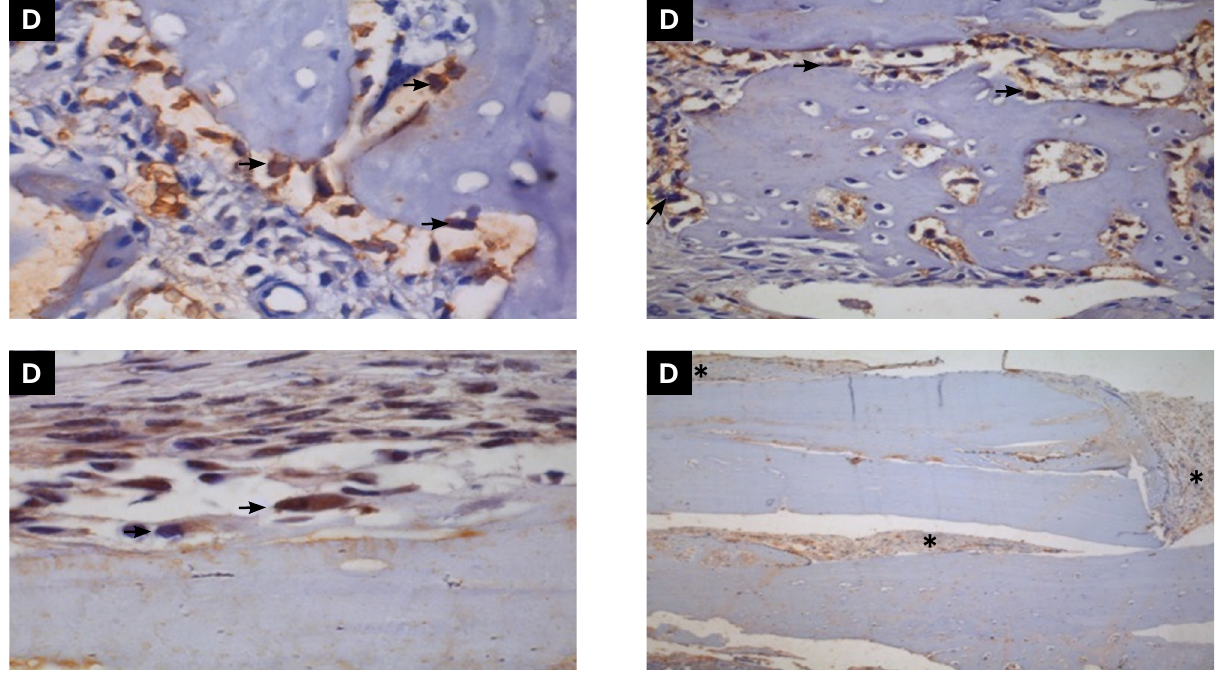
Figure 3. Photomicrographs showing the OPG staining a) Day 7 Group OVX-E: moderate labeling of osteoblasts ( → ) of newly formed bone x400. b) Day 7 Group SHAM-E: moderate labeling of osteoblasts ( → ) of newly formed bone x400. c) Day 21 Group OVX-ME: